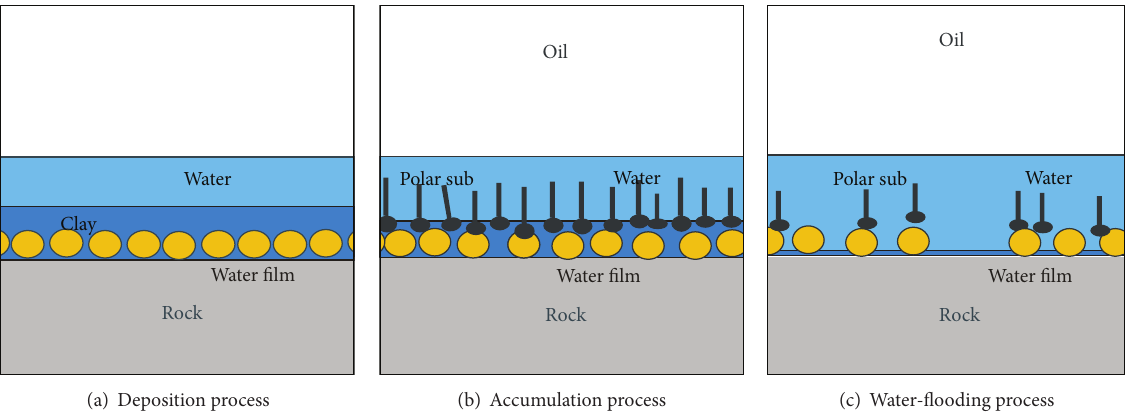
Figure 1: Wettability variation during reservoir formation